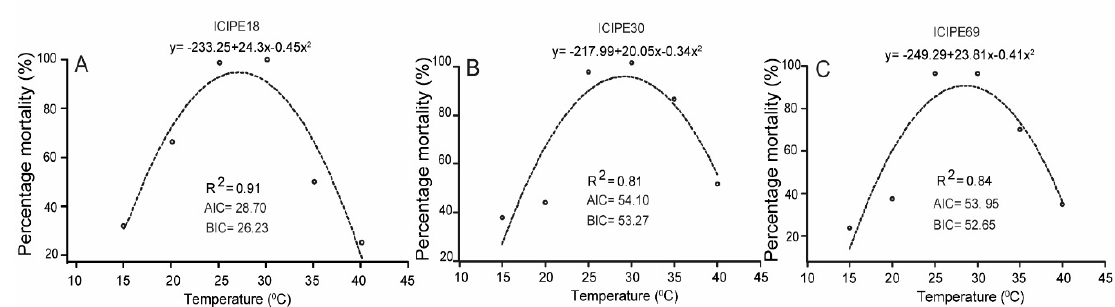
Figure 3. Temperature-dependent percentage mortality rates of adult Z. cucurbitae . ICIPE 18 ( A ), ICIPE 30 ( B ) and ICIPE 69 ( C ). Markers are observed mean mortalities. AIC is Akaike information criterion and BIC is Bayesian information criterion.